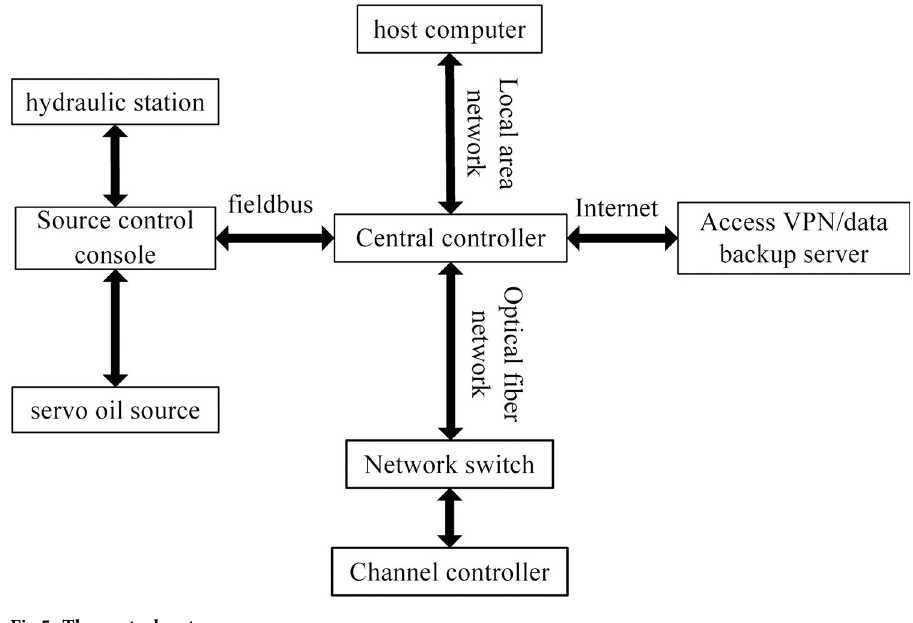
Fig 5. The control